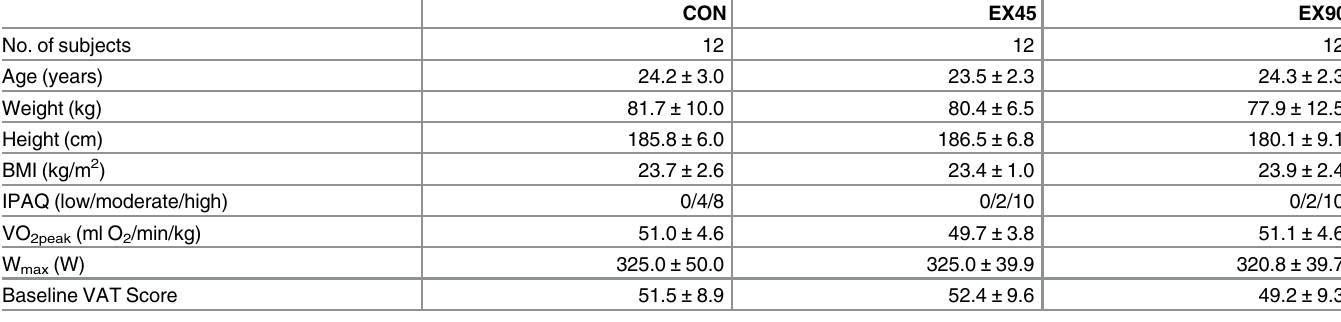
Table 1. Descriptive data of study participants (group mean ± SD).